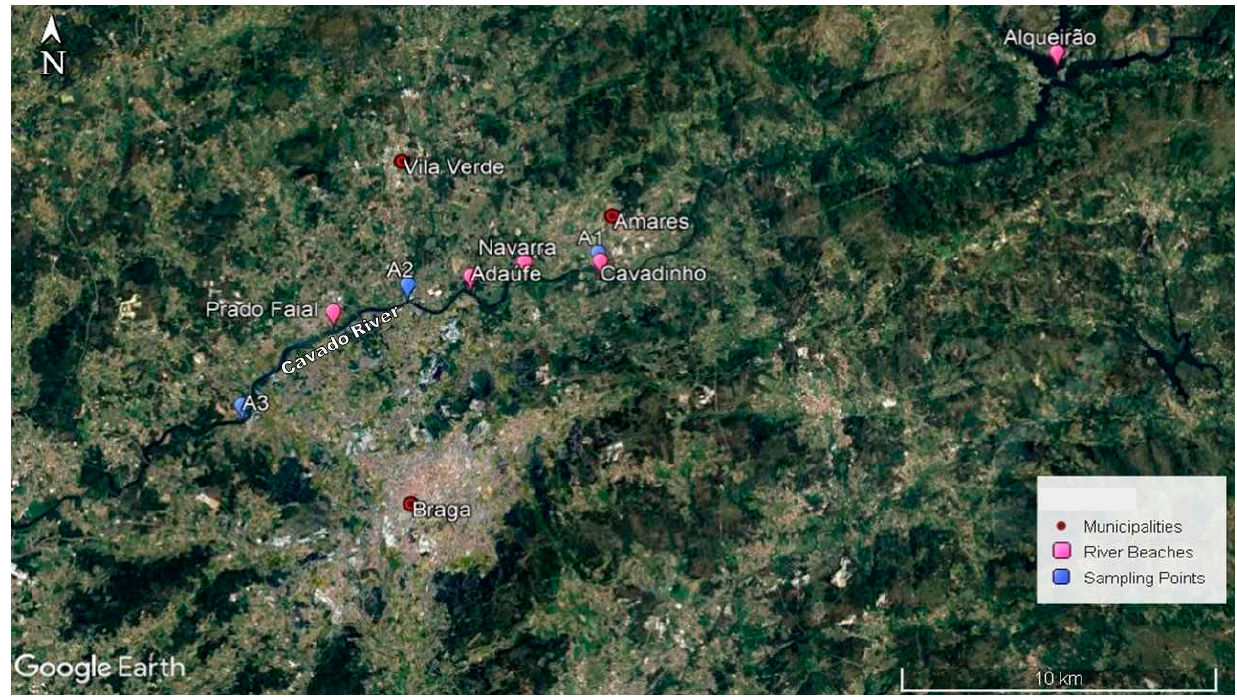
Figure 3. Location of the river beaches of: Alqueirão, Cavadinho, Navarra, Adaúfe, and Prado Faial, and water sampling points (A1–A3) in Cávado River (Google Earth).